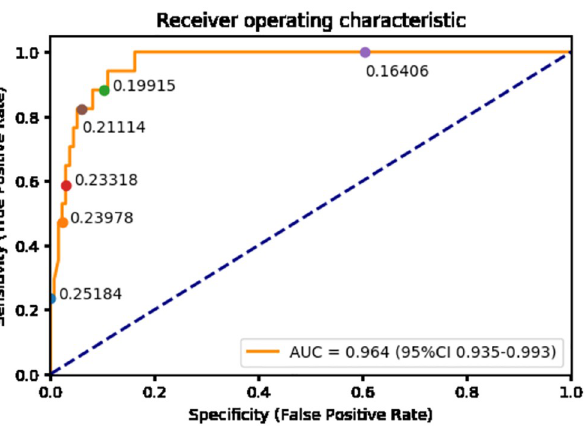
Fig 6. Receiver operator characteristic curve at different thresholds of ONSD/ETD index.